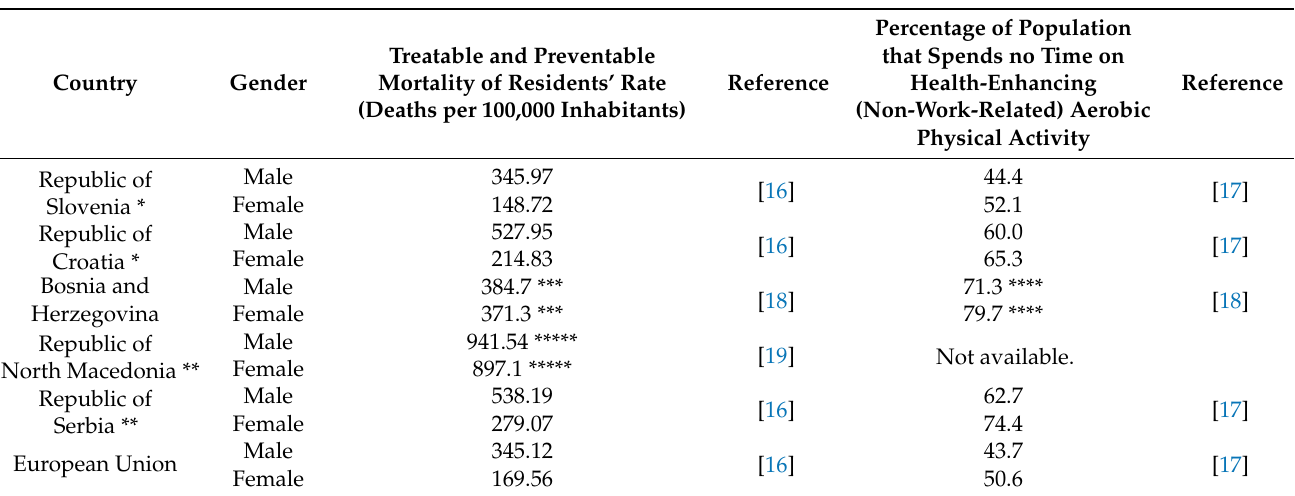
Table 1. The treatable and preventable mortality rate and the percentage of the population that does not spend time on aerobic physical activity that improves health (unrelated to work) in relation to